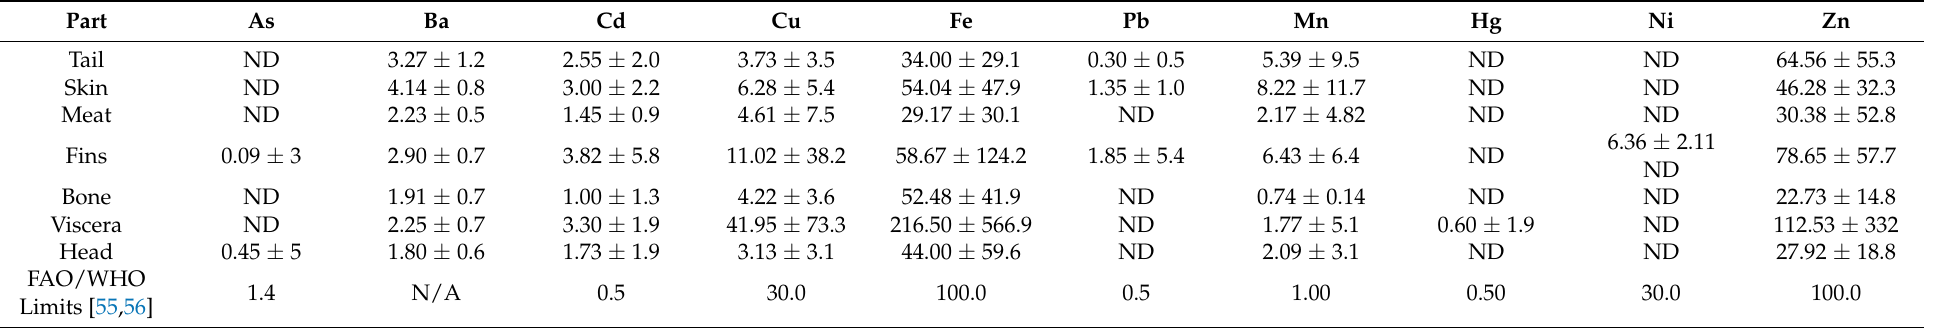
Table 4. Mean concentration of HMs (mg kg − 1 ) in various parts of Tilapia